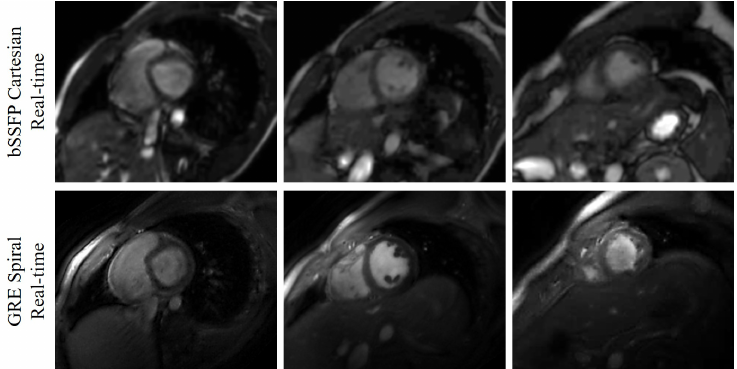
Figure 3. Comparison between the bSSFP Cartesian real-time images with acceleration factor 5 and the GRE spiral real-time images reconstructed using the deep kernel method. The three slices (one basal slice, one mid slice, and one apex slice) are from Subject #3. The first row shows the bSSFP Cartesian real-time images, and the second row is the GRE spiral real-time